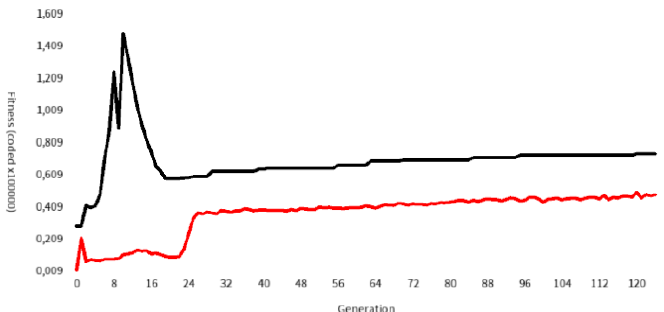
Figure 8: Calculated fitness of the swarm